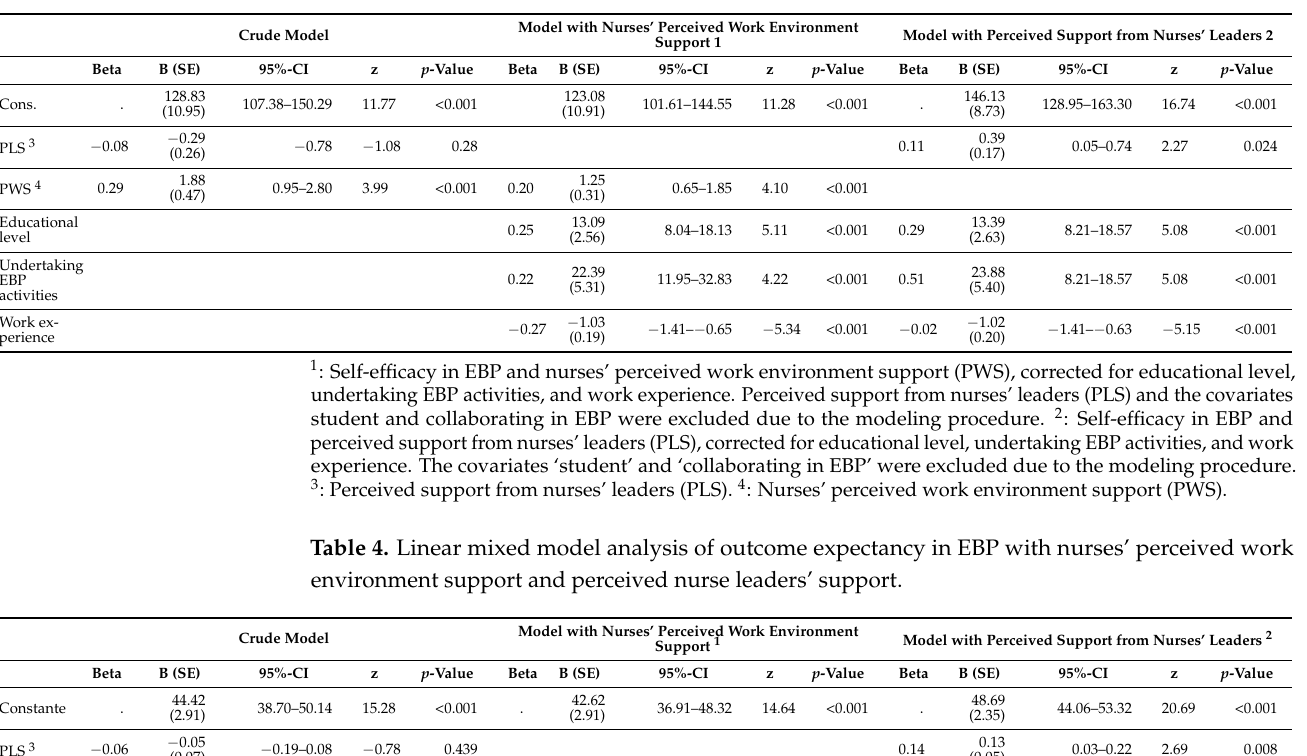
Table 3. Linear mixed model analysis of self-efficacy in EBP with nurses’ perceived work environment support and perceived nurse leaders’ support.